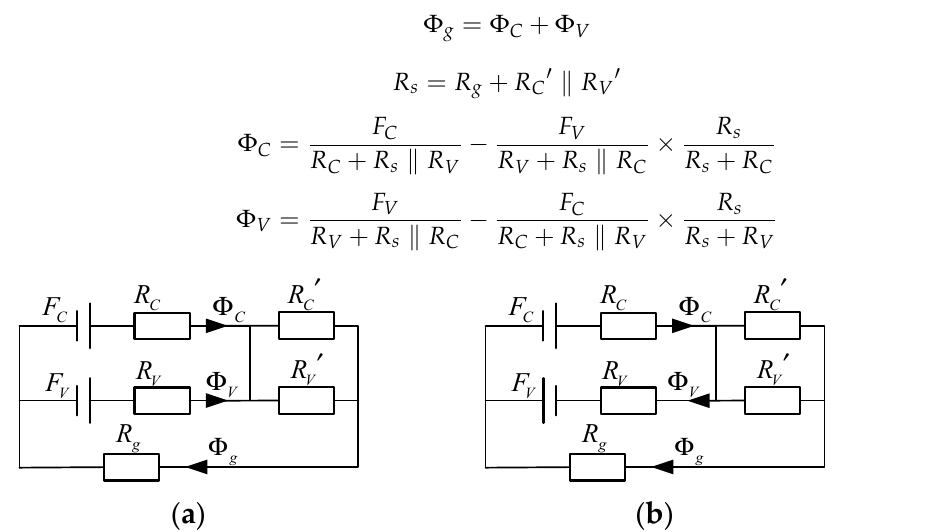
Figure 2. Equivalent magnetic circuits. ( a ) Forward parallel equivalent magnetic circuit; ( b ) reverse parallel equivalent magnetic circuit.